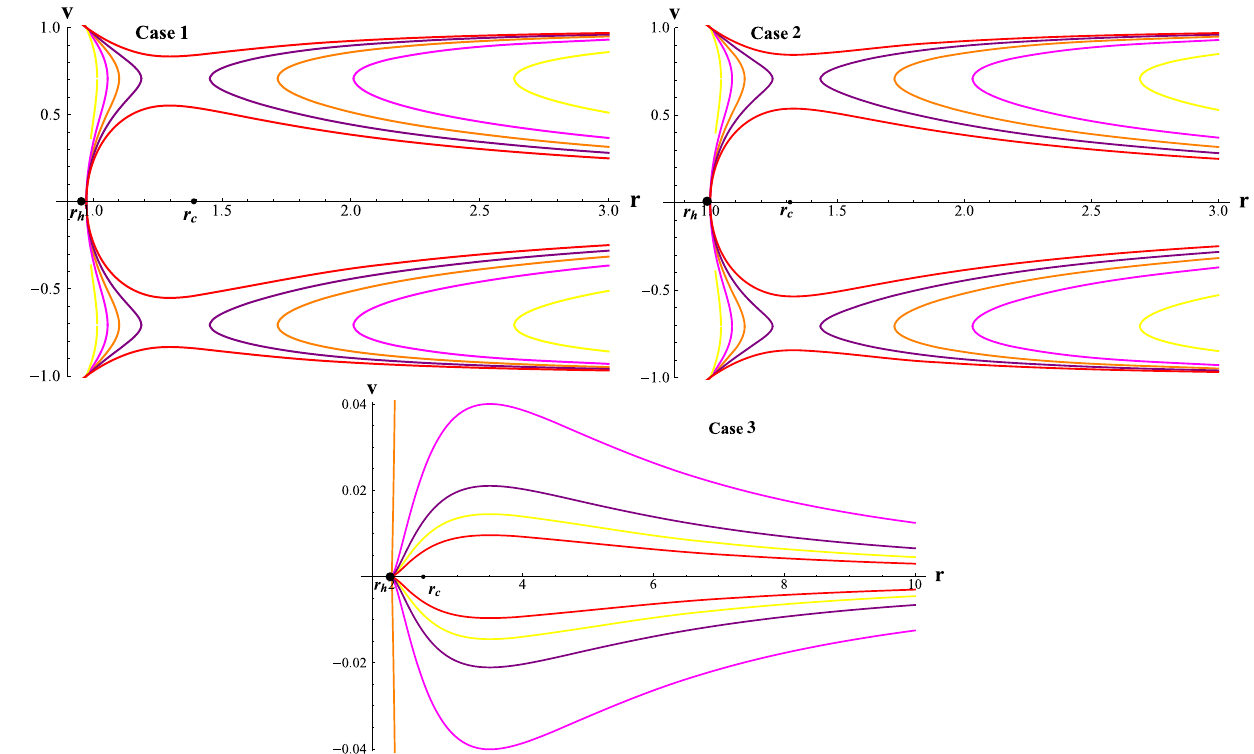
Fig. 4 For the accretion flow, the left panel (conformal gravity BH) displays the behavior of Eq. (39) with conformal parameters γ = 0 . 1, k = − 1, β = 1. The critical parameters involve r c ≈ 1 . 29701, v = 0 . 70716, H ≈ 1 . 30306. Right panel (Schwarzschild–de Sit- c c ter BH) displays the behavior of (39) with Schwarzschild–de Sitter BH parameters γ = 0, k = − 1, β = 1. The values of the critical